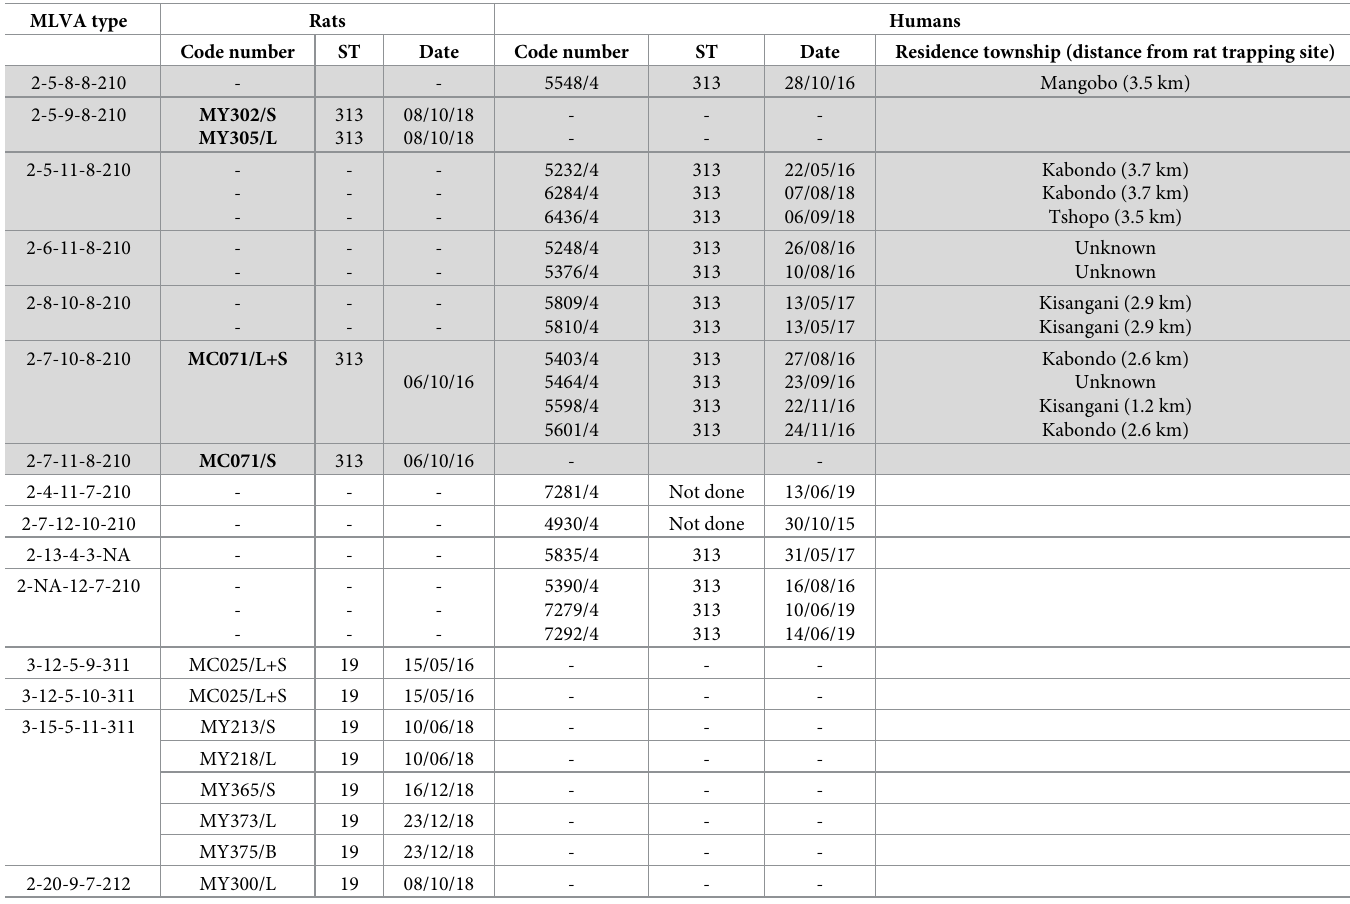
Table 3. MLVA types of Salmonella Typhimurium isolated from rats and human blood cultures. NA corresponds to a locus on which no allele has been amplified. The two groups of grey shaded cells present MLVA clusters of rat (bold) and human isolates. Two rats (MC071 and MC025) had each two different MLVA types. Code numbers of rats refer to sampling site: AB = Slaughterhouse (Abattoir) Mangobo, MC = Marche´ Central, MY = Marche´ Yate´; and specimen type: S = spleen, L = liver, B = blood, ND = no data. MLVA type